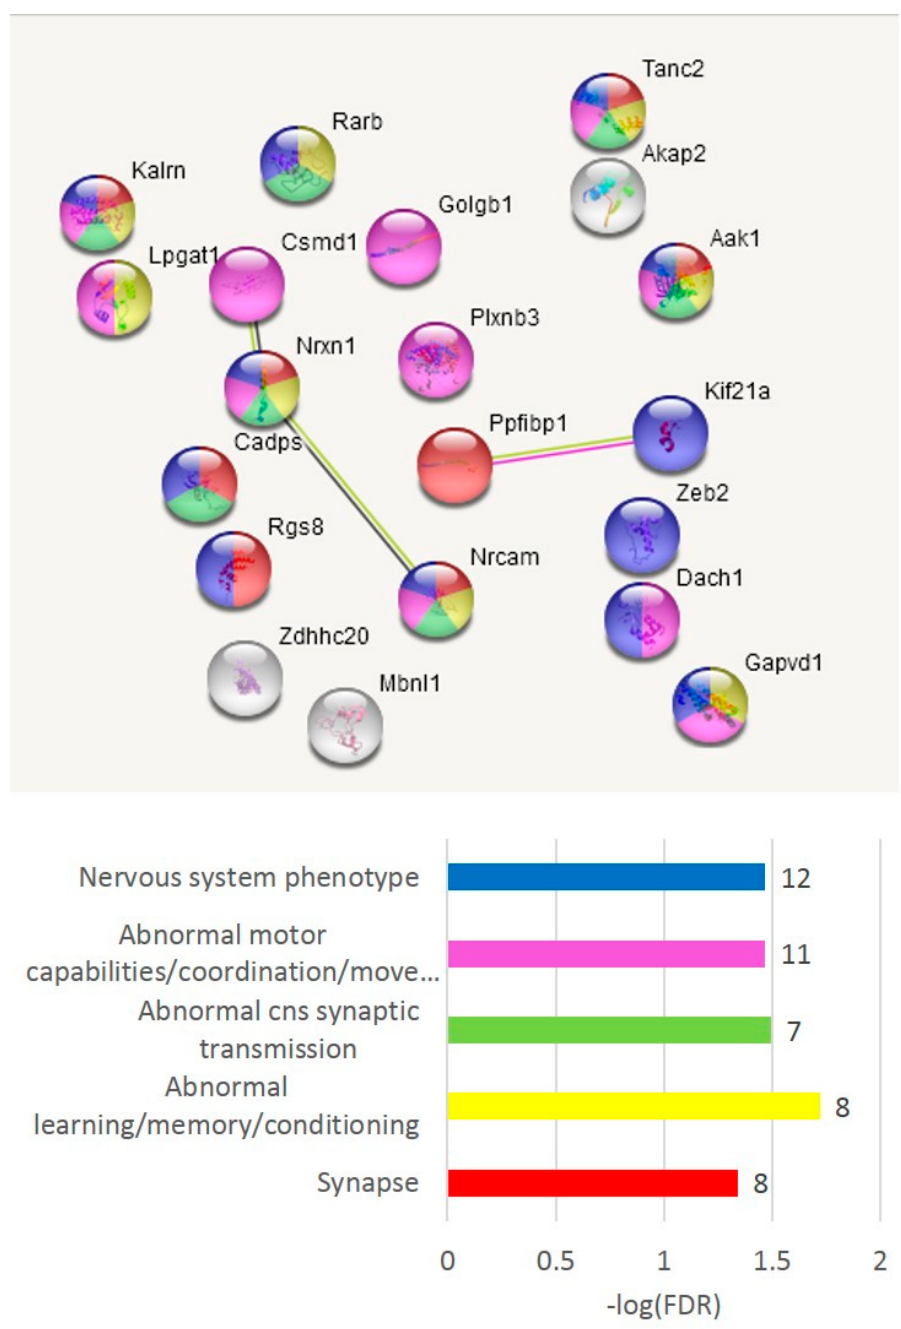
Figure 10. The 20 distinct DAS ES genes overlapping DEGs [4] (Table S3a,b). Color codes are shown as a bar plot with the number of DEGs/DAS genes attached as labels. We identified DAS ES Mbnl1 SF gene, which significantly elevated its expression in aggressive subjects. The GO categories (Monarch MPO; monarchinitiative.org; embedded in string-db.org project) reflect the DS brain region phenotype features in the essential part. See the description of full GO annotation/genes in Table